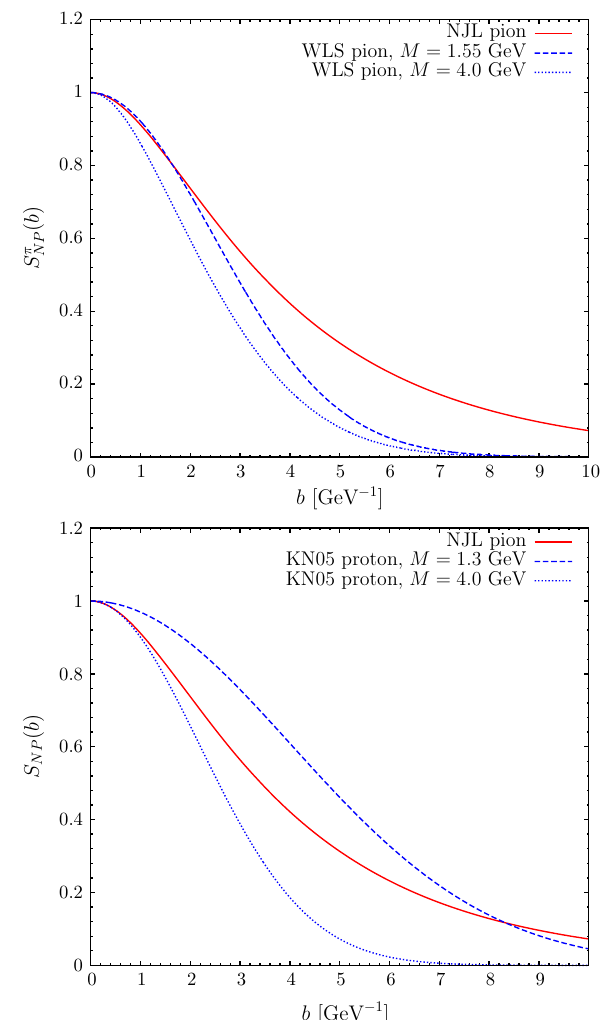
Fig. 3 Transverse profile in b -space for the NJL pion, Eq. (19), com- pared, in the top panel, to the profile of the WLS pion [22] and, in the bottom panel, to that of the KN05 proton, different values of the scale